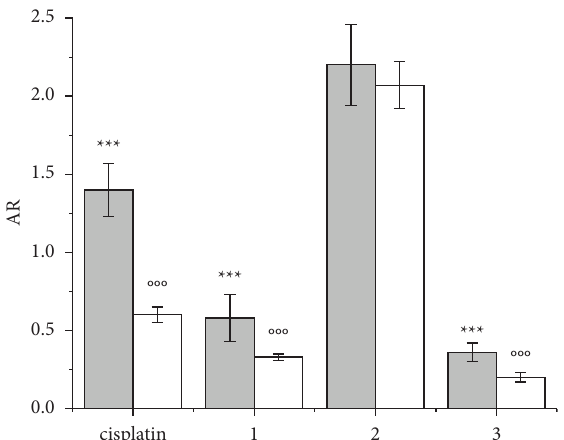
Figure 9: Expression of Ctr1, OCT1, OCT2, and OCT3 mRNA in A2780cisR (cisplatin resistant; white bars) cells compared to A2780 (wild type; gray bars). Data are the mean ± SD of three independent replicates and were compared using one-way analysis of variance (ANOVA) with the Tukey post-hoc test. Statistical analysis (A2780cisR vs. A2780): ∗∗ p < 0.01).